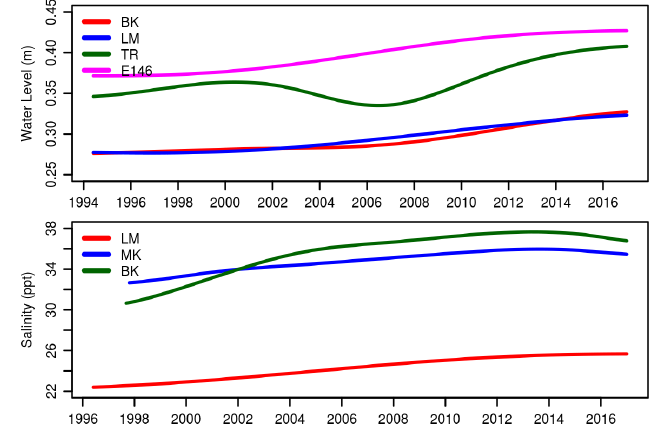
Figure 12. Nonlinear trends of water level and salinity at hydrographic stations in Florida Bay and Taylor Slough.